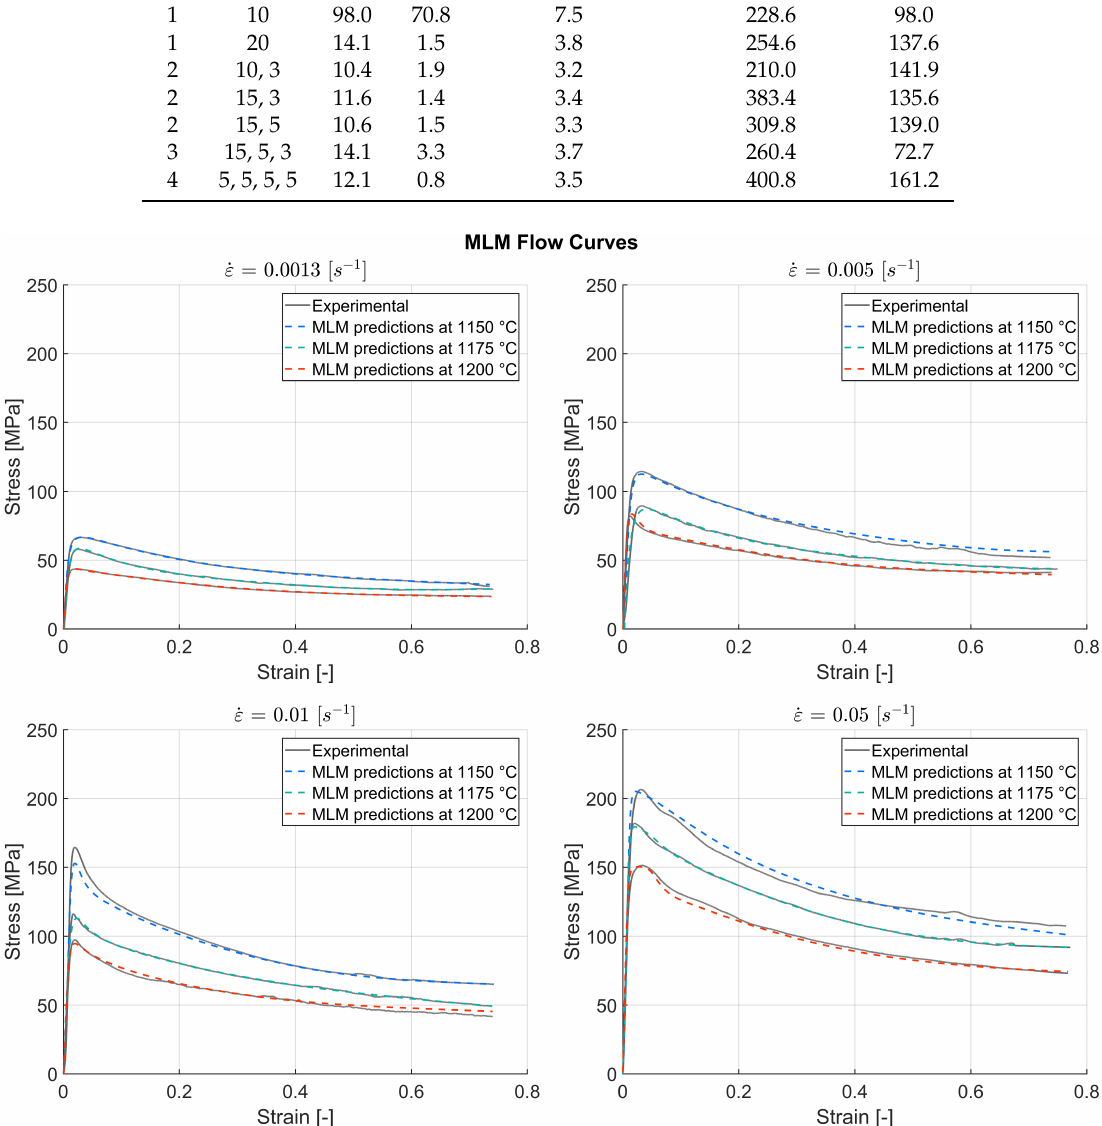
Figure 8. Experimental flow curves and the MLM predictions for TNM-B1 at the temperatures 1150, 1175 and 1200 ◦ C and the strain rates 0.0013, 0.005, 0.01 and 0.05 s –1